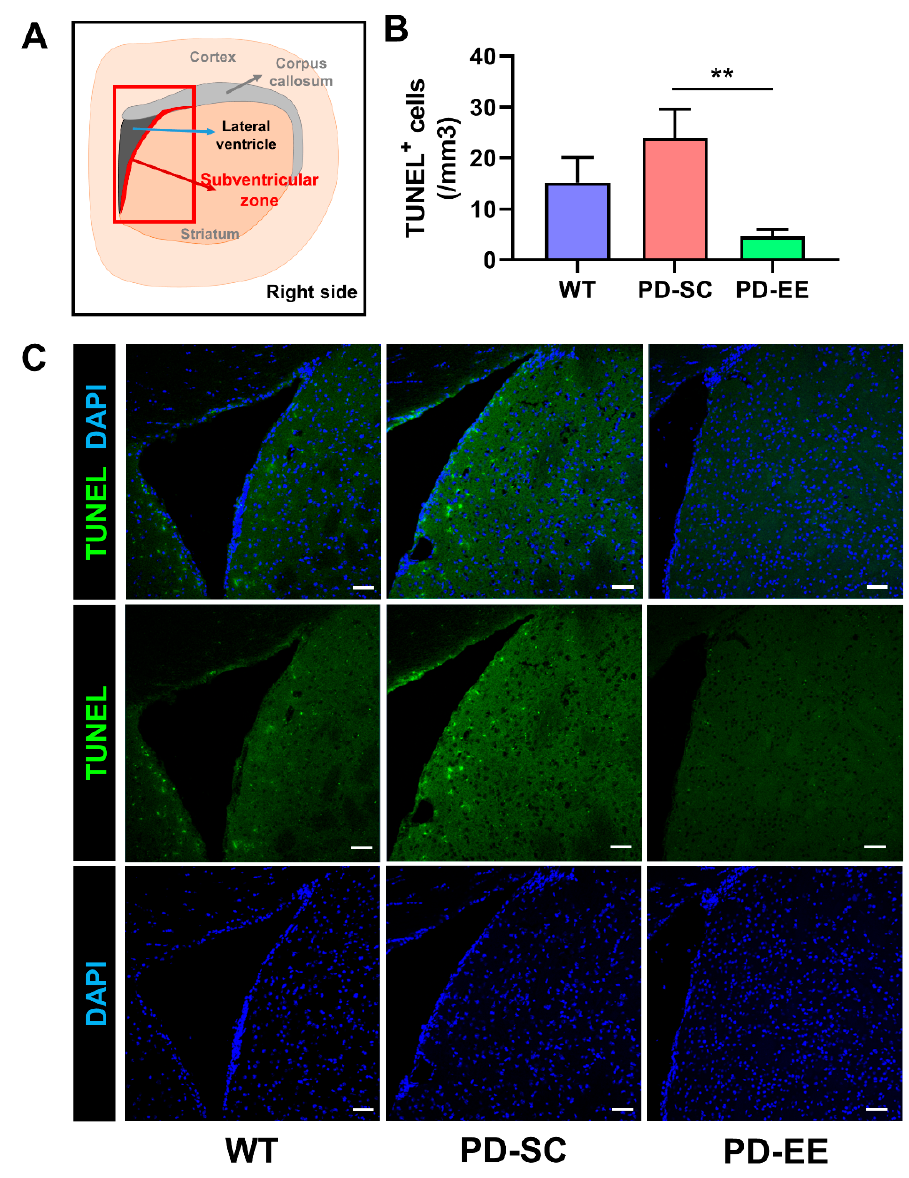
Figure 4. EE decreased apoptotic cell death in the subventricular zone (SVZ) of PD mice. ( A ) The number of terminal deoxynucleotidyl transferase deoxyuridine triphosphate (dUTP) nick end labeling (TUNEL) + cells were evaluated in the SVZ. ( B ) The number of TUNEL + cells were significantly decreased in the PD-EE mice compared to the PD-SC mice ( n = 3, each). ( C ) Representative confocal microscopic images of TUNEL + cells in the SVZ of coronal sections. Blue color indicates 4 ′ ,6-diamidino-2-phenylindole (DAPI) + nuclei. The scale bar represents 50 μ m. ** p < 0.01; one-way ANOVA followed by post-hoc comparison.